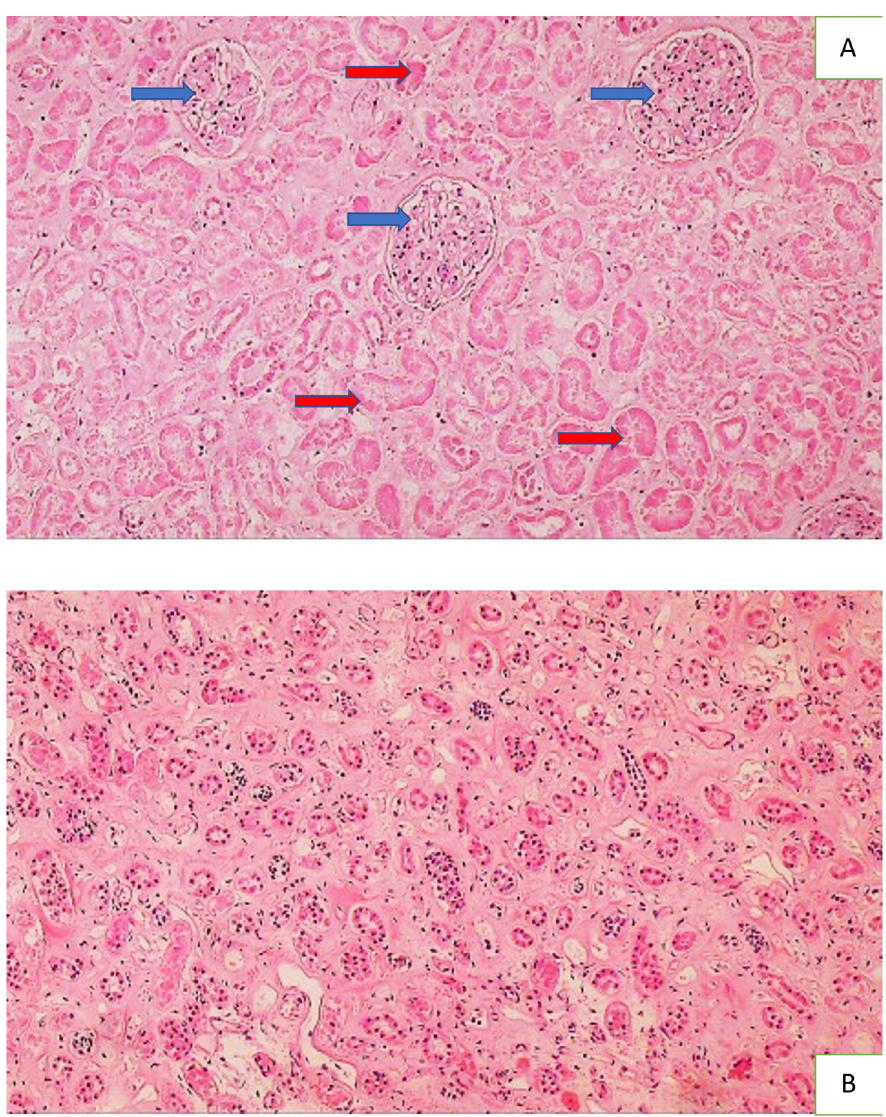
Figure 4. Histology of the kidney of a COVID-19 patient with acute tubular necrosis ATN. Photo ( A ) shows acute tubular necrosis in the renal tissue, presented by the necrotic epithelium (no cells with nuclei present) of the proximal and distal convoluted tubules (red arrows) and the preserved glomeruli (blue arrows) (HE, 100×), while Photo ( B ) shows the preserved epithelium containing the nuclei (dark spots) of collecting tubules (HE, 100×).